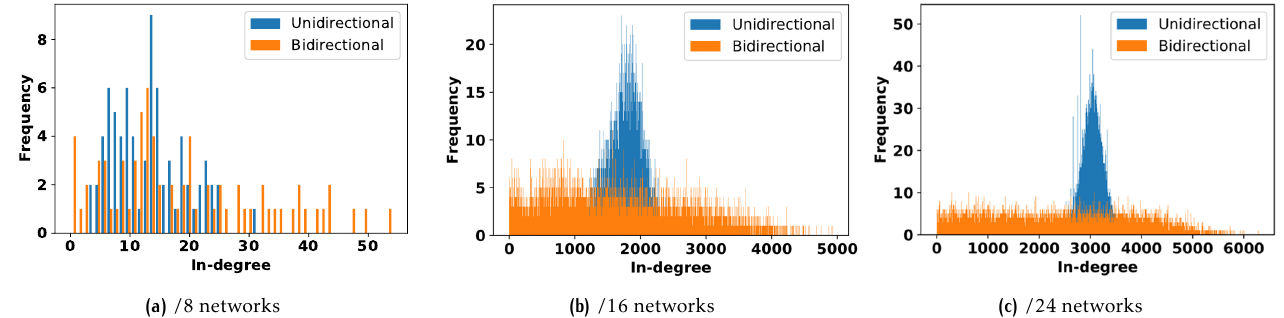
Figure 7. Plot of the density (i.e., frequency) of the nodes’ in-degrees in the G-causality graph G is reasonable because a lower resolution network is composed of a number of higher resolutions